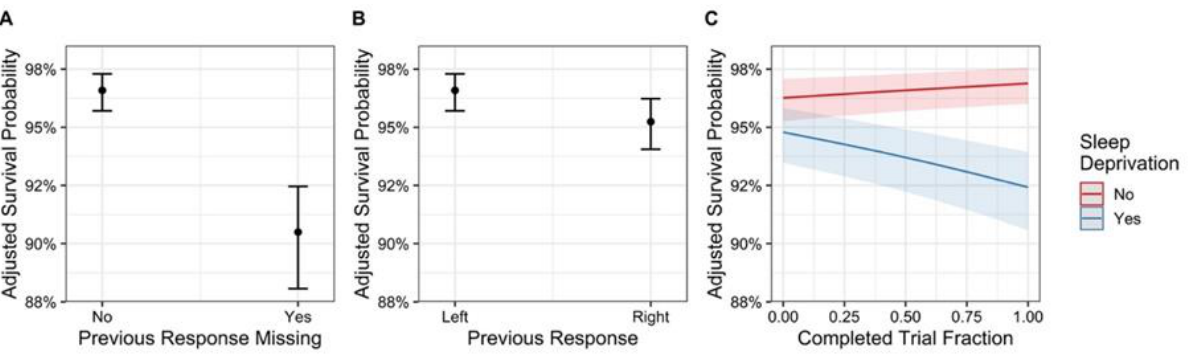
Figure 3. (A) Condition effects of previous response missing, ( B ) previous response left or right, and ( C ) interaction effect of sleep condition (sleep deprivation no (“normal sleep” group) in red and sleep deprivation yes (“sleep deprived” group) in blue) by completed trial fraction. Error bars and bands represent 95% confidence intervals.